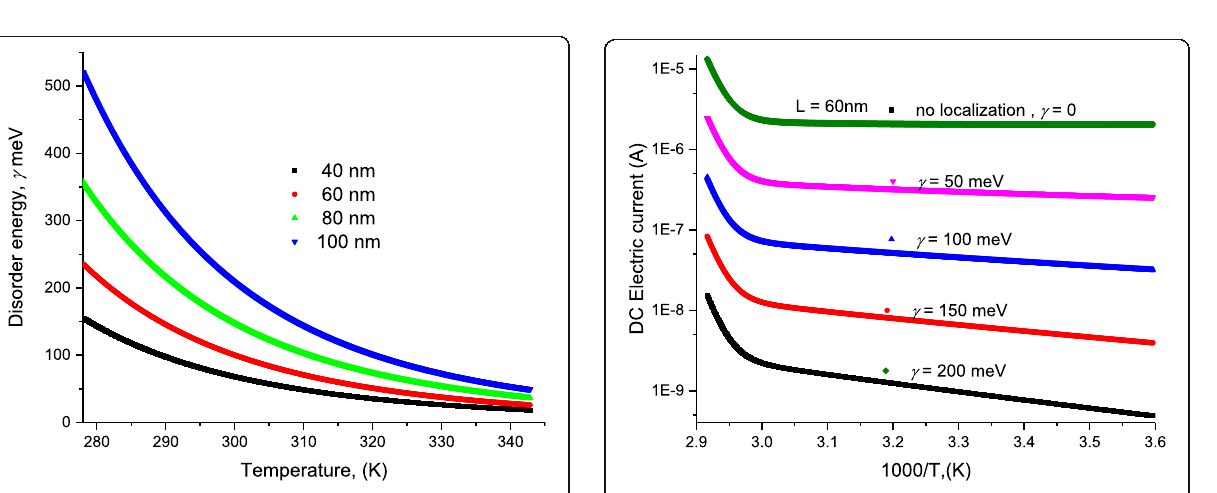
AC Electrical Conductivity: Thermal Effect on Localized Charges Fixing the length of DNA molecule at 60 nm, Fig. 14 illustrates the measured AC-conductivity as a func- tion of frequency for DNA molecule, for different temperatures. Lines represent calculated values after Eq. (12) with the data in Figs. 8 and 9. Symbols rep- resent experimental values. Figure 14 illustrates the thermal-effect on four humps (H2, H3, H4, and H5).